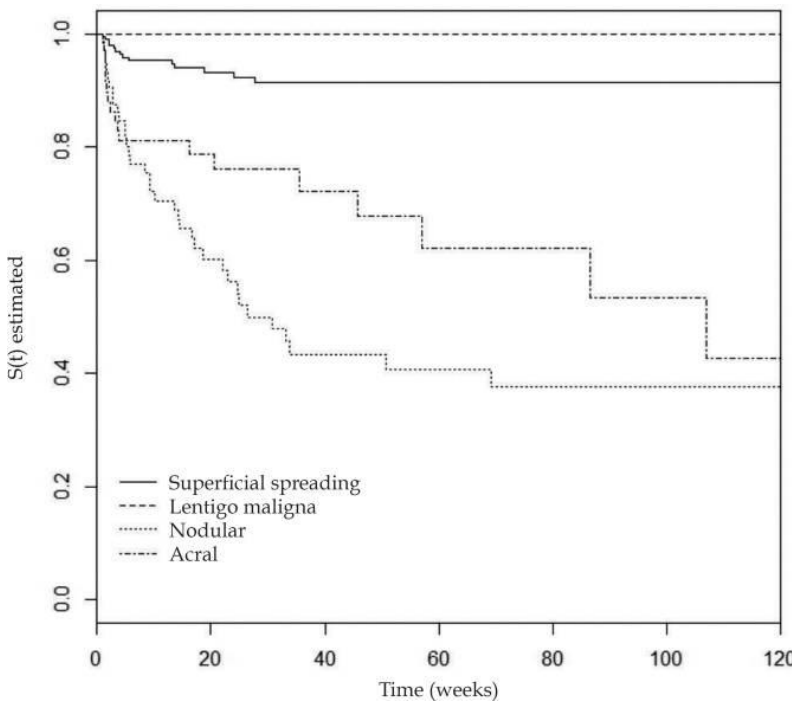
Figure 1. Estimated time to metastasis of melanoma subtypes (reproduced from “Prognostic factors for metastasis in cutaneous melanoma” by Cherobin et al. and is licensed under CC BY-NC-ND 3.0 from [7]). Kaplan–Meier curve showing the four different major subtypes of melanoma and the time (in weeks) for the development of metastasis in patients with primary cutaneous melanoma in the timespan of 1995–2012 [7]. This emphasizes the need for the early detection and diagnosis of melanoma.